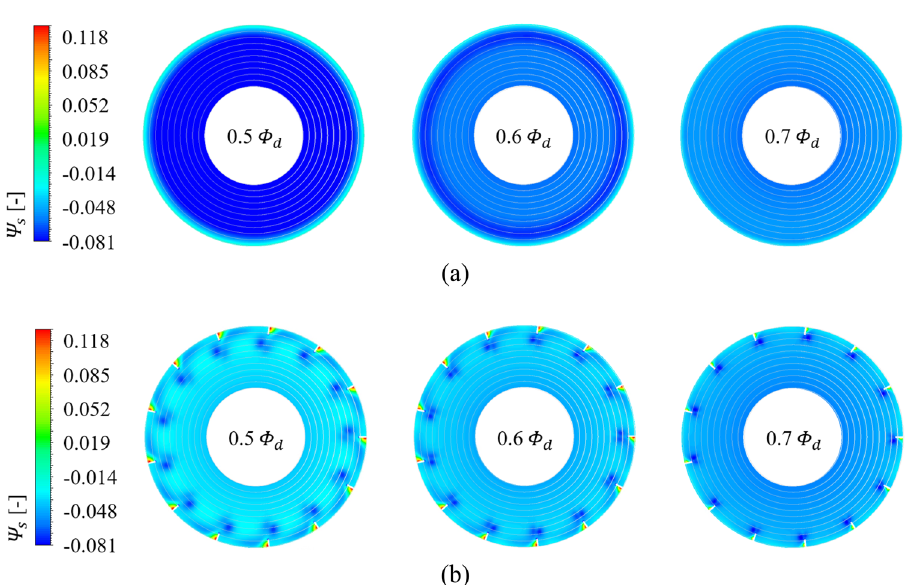
Figure 11. Static pressure ( Ψ s ) contour on sectional plane for each (a) case of none and (b) ASF attached (0.5–0.7 Φ d